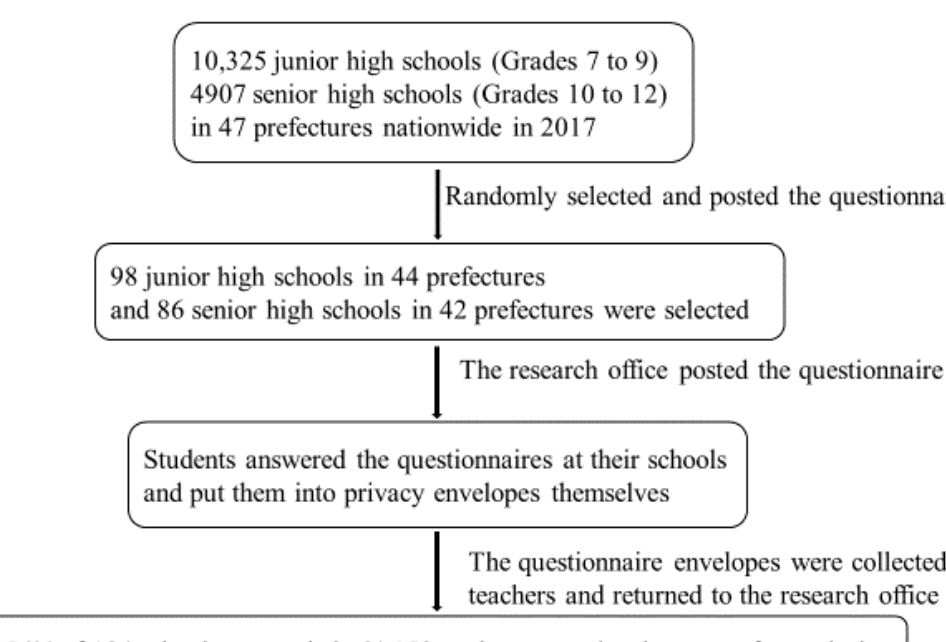
Figure 1. Flowchart of data collection.